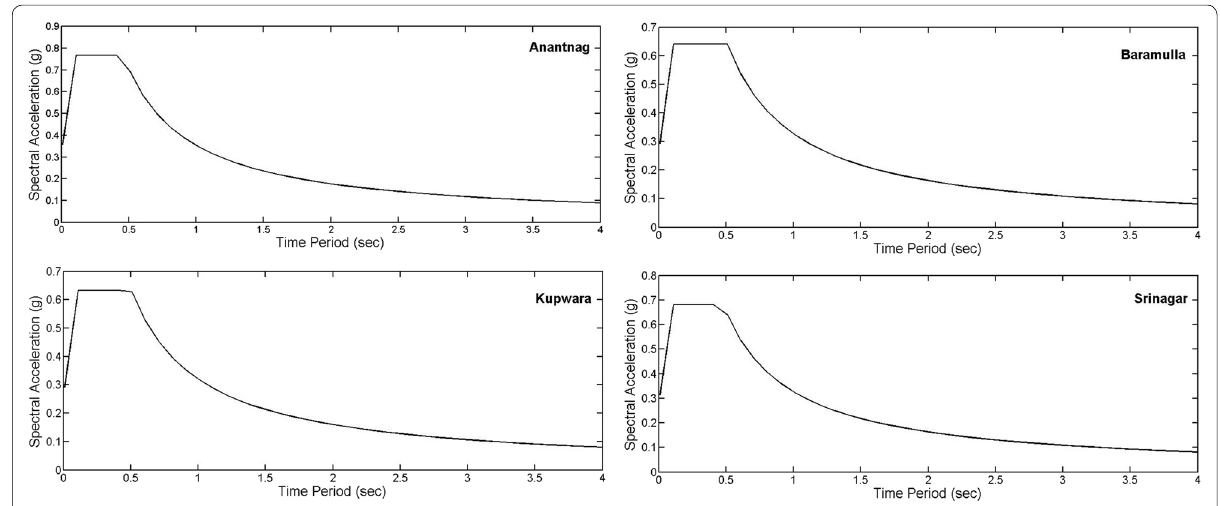
Fig. 9 Design response spectra with 5% damping for major towns of Kashmir basin: Anantnag, Baramulla, Kupwara and